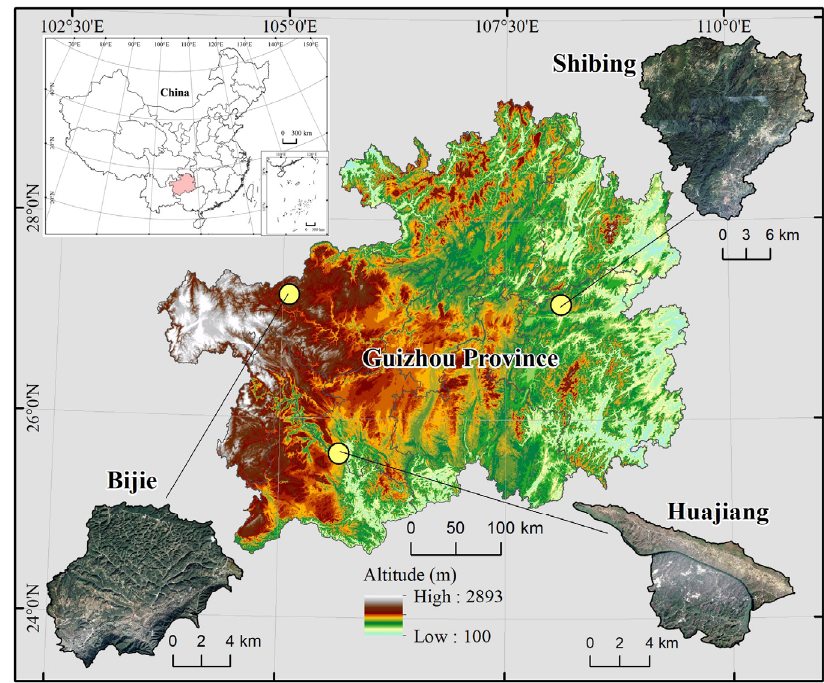
Figure 1. Topographic map of the study area.